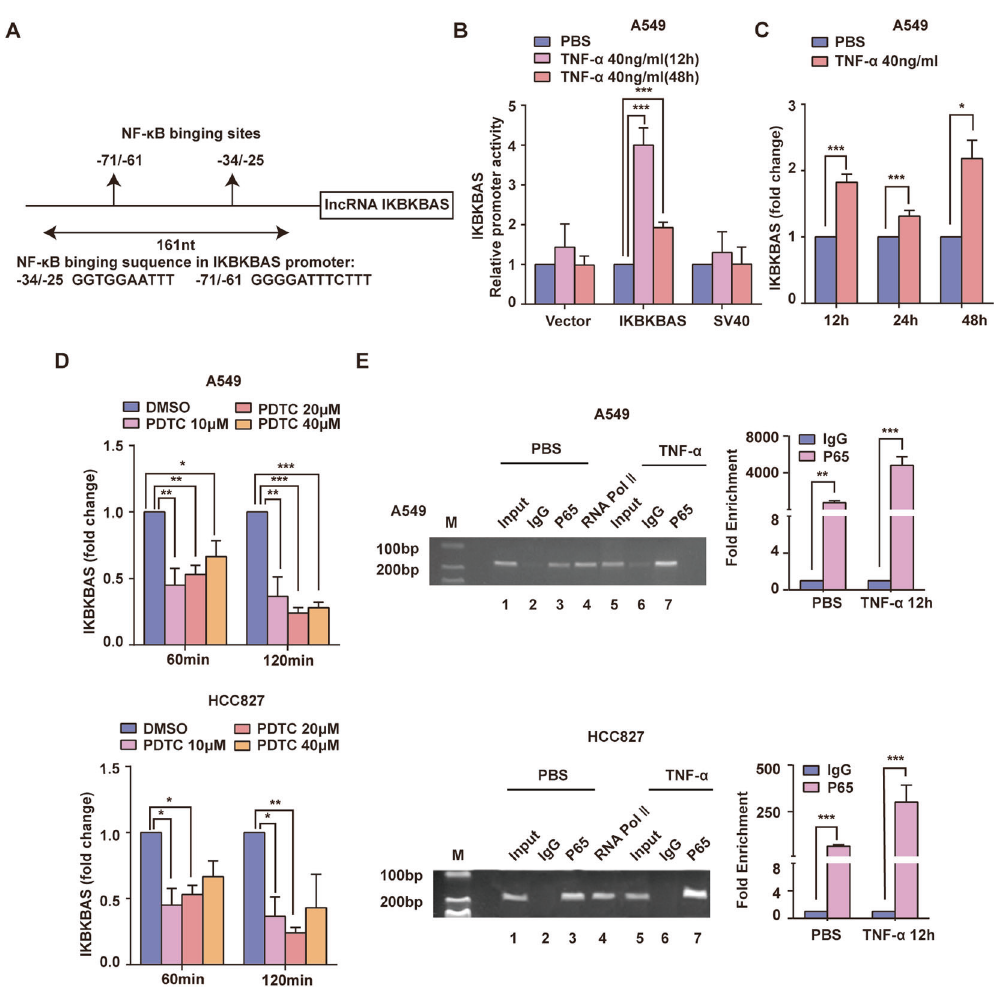
Fig. 7 Reciprocal positive regulation between IKBKBAS and NF- κ B. A Schematic representation of the predicted binding sites for NF- κ B on IKBKBAS promoter for ChIP assay. B Luciferase reporter assay showing the relative promoter activity of IKBKBAS in A549 cells treated with TNF α 40 ng/ml for 12, 24 h, respectively. C The expression of IKBKBAS in A549 cells treated with TNF α 40 ng/ml for 12, 24, 48 h was detected by qRT-PCR, respectively. D Expression of IKBKBAS detected in A549 cells and HCC827 cells with treatment of PDTC (10, 20, 40 μ M) for 60 min, 120 min by qRT-PCR. E The interaction between p65 and two κ B sites on IKBKBAS promoter were assayed by ChIP experiments. The anti-p65 or IgG antibody (negative control) or anti-RNA pol II (positive control) in A549 cells and HCC827 cells treated with TNF α (40 ng/ml) for 12 h were performed. Left: the RT-PCR results (lane M: marker; lanes 1 – 3 & 5 – 7: IKBKBAS promoter DNA fragment containing 2 κ B sites, 161 bp; lane 4: GAPDH promoter DNA fragment: 166 bp); right: qRT-PCR results. Y axis represents the % input of the promoter fragments captured by the two different antibodies. Data show mean ± S.E.M., n ≥ 3, * P < 0.05, ** P < 0.01, *** P <